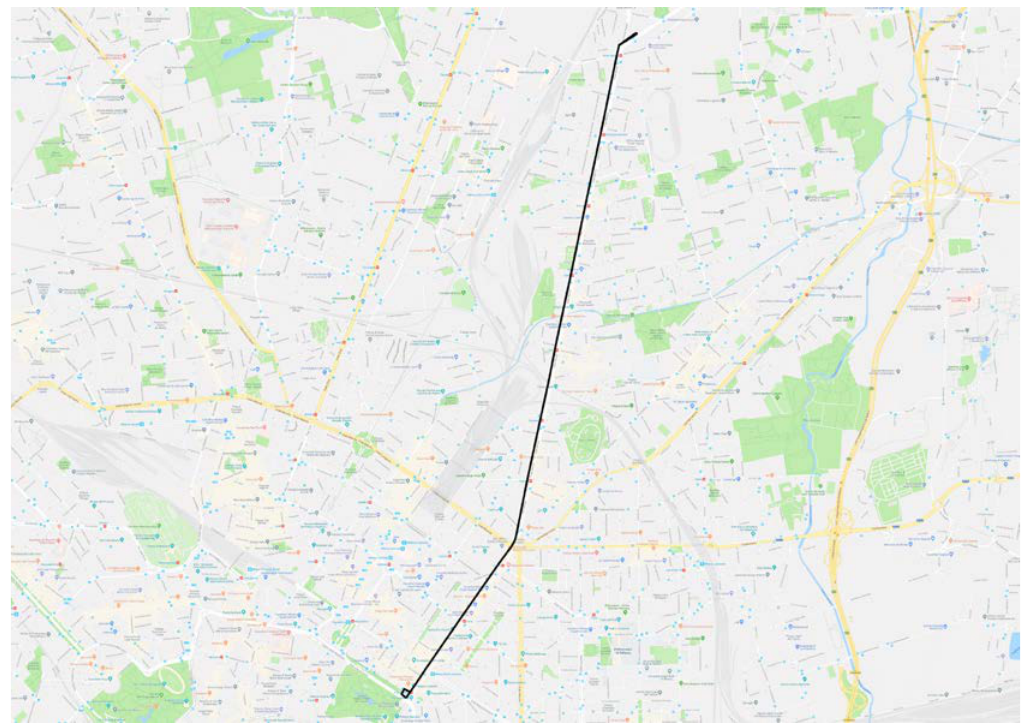
Figure 6. Path selected for the second set of experiments (QGIS elaboration of Google Maps).